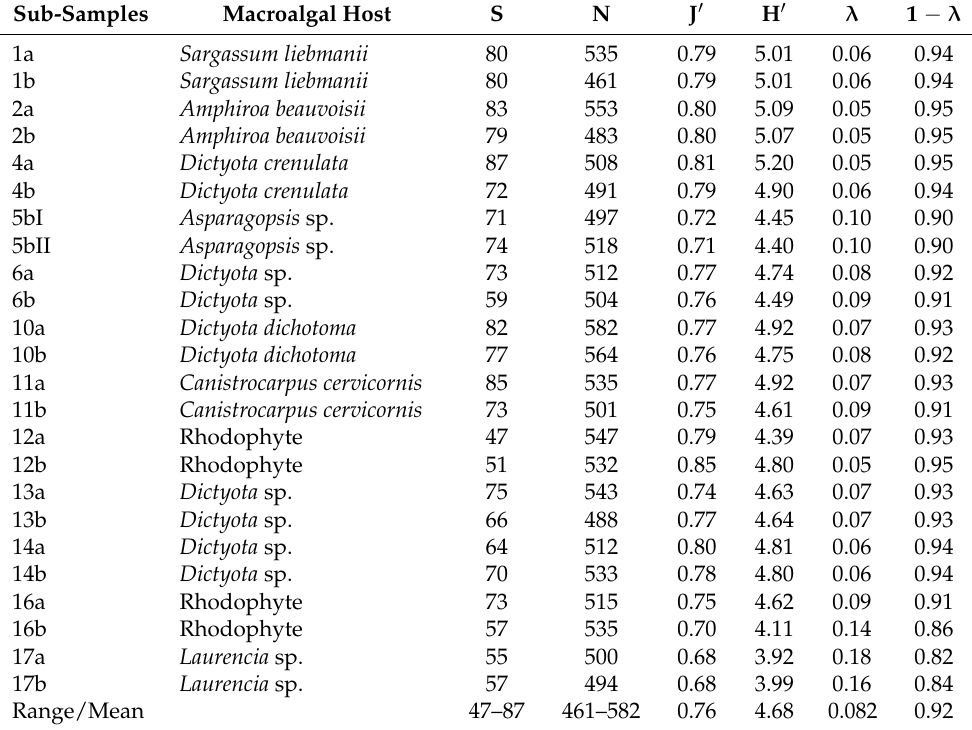
Table 3. Diversity values computed for the diatom taxa found on macroalgae hosts from the Revil- lagigedo Archipelago, Mexico.